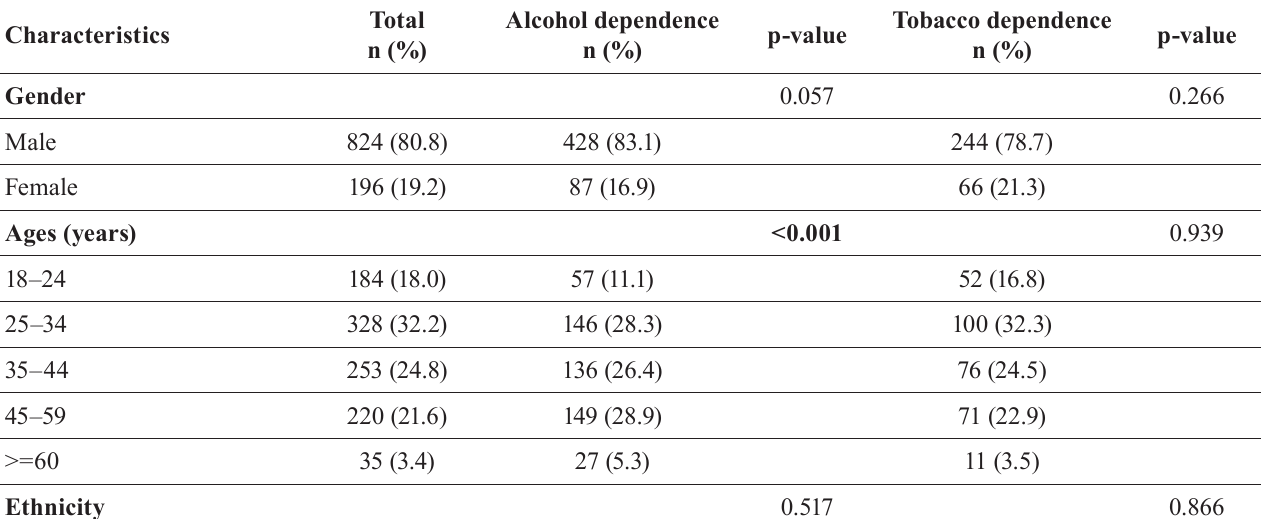
TABLE I - C haracteristics of surveyed subjects regarding alcohol and tobacco dependence and its association with demographic and clinical